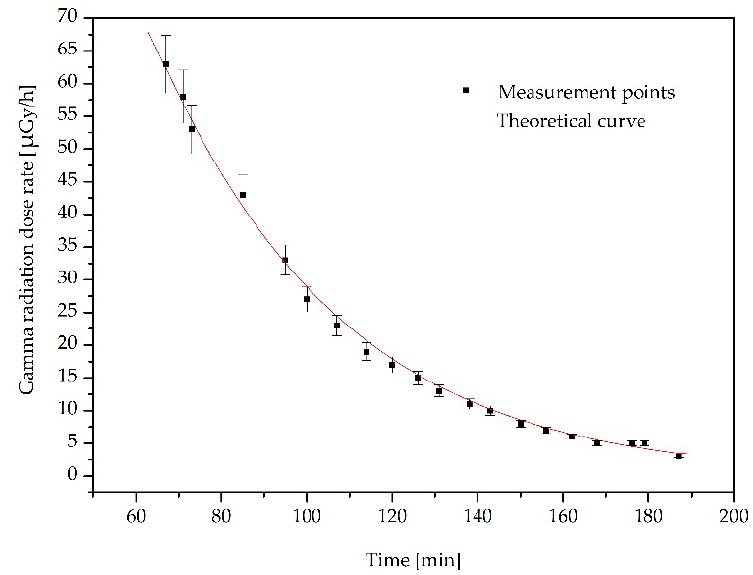
Figure 2. Gamma radiation dose rate as a function of time.